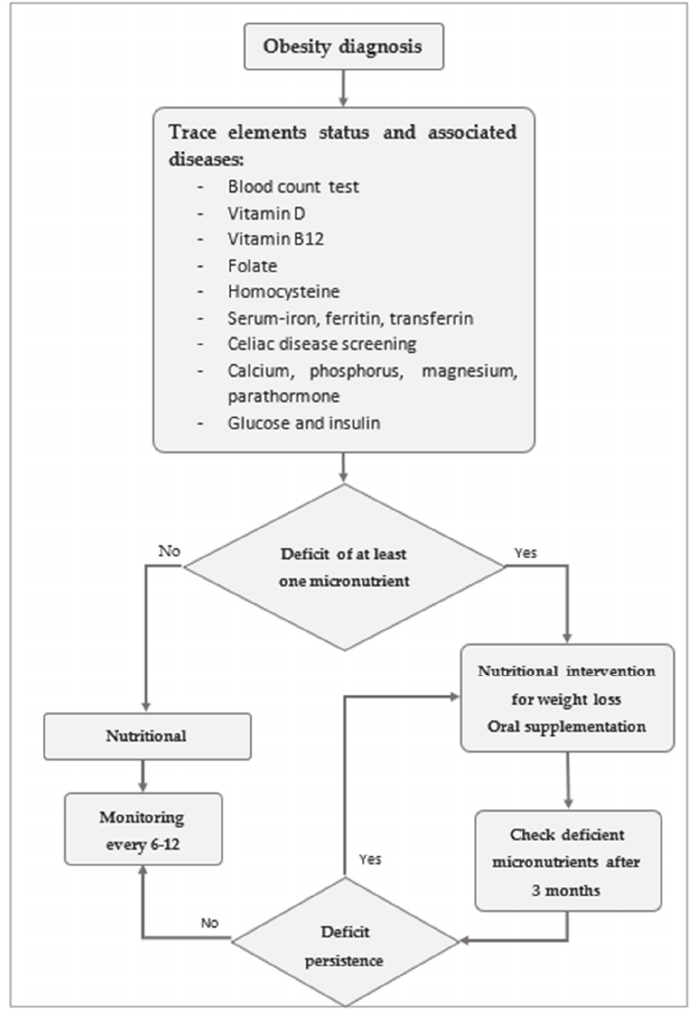
Figure 3. Micronutrient monitoring process.